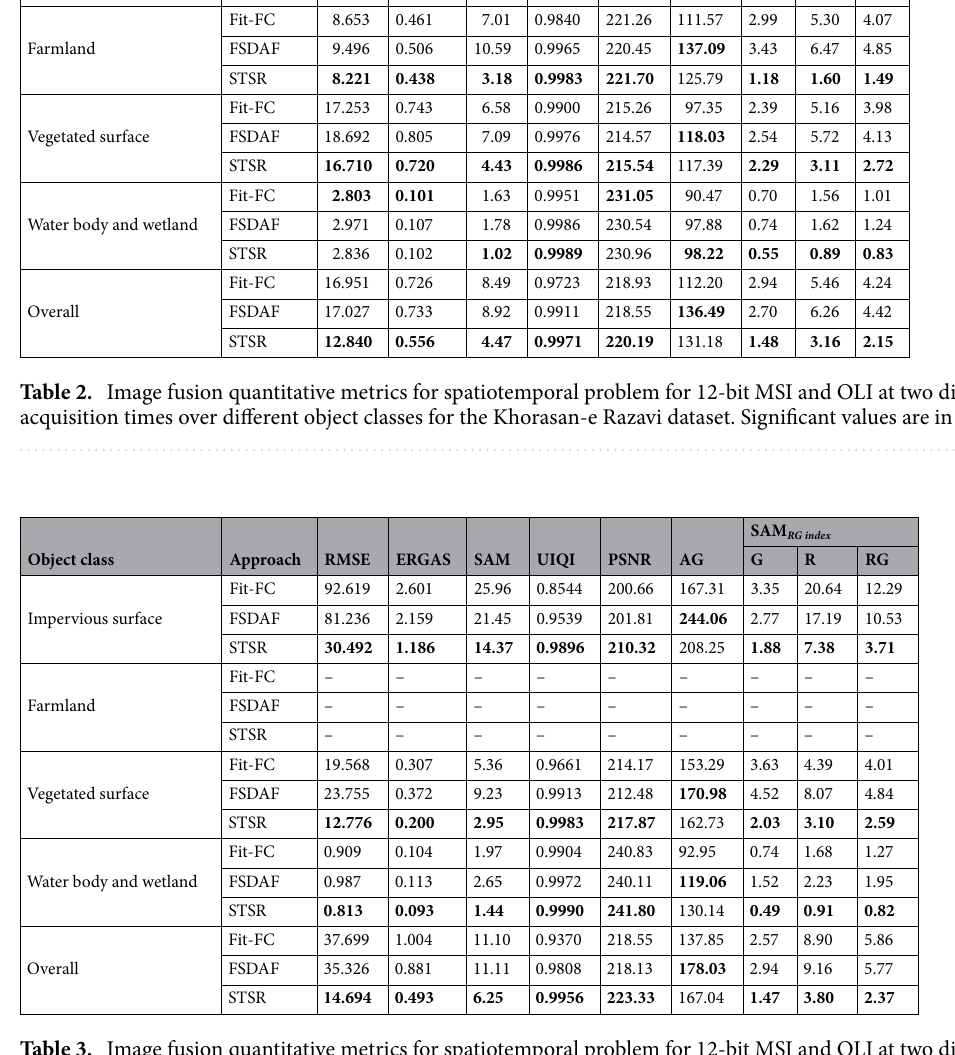
Table 3. Image fusion quantitative metrics for spatiotemporal problem for 12-bit MSI and OLI at two different acquisition times over different object classes for the Tehran dataset. No object class with the farmland label was detected in this area. Significant values are in